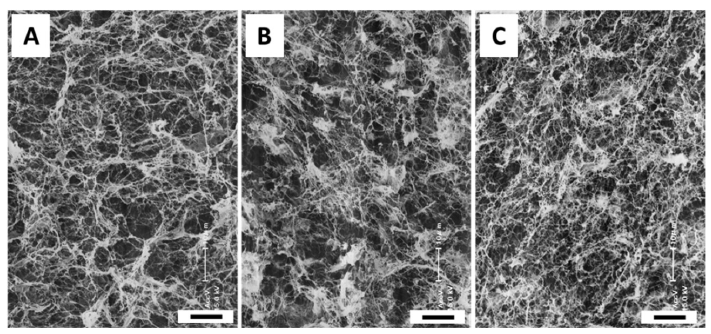
Figure 6. ( A ) SEM images of 3 mg/mL I Col gel, ( B ) 10 mg/mL L-ECM gel, and ( C ) 20 mg/mL L-ECM gel samples (all images are shown at a magnification of 1000 times. Scale bar = 10 μm).